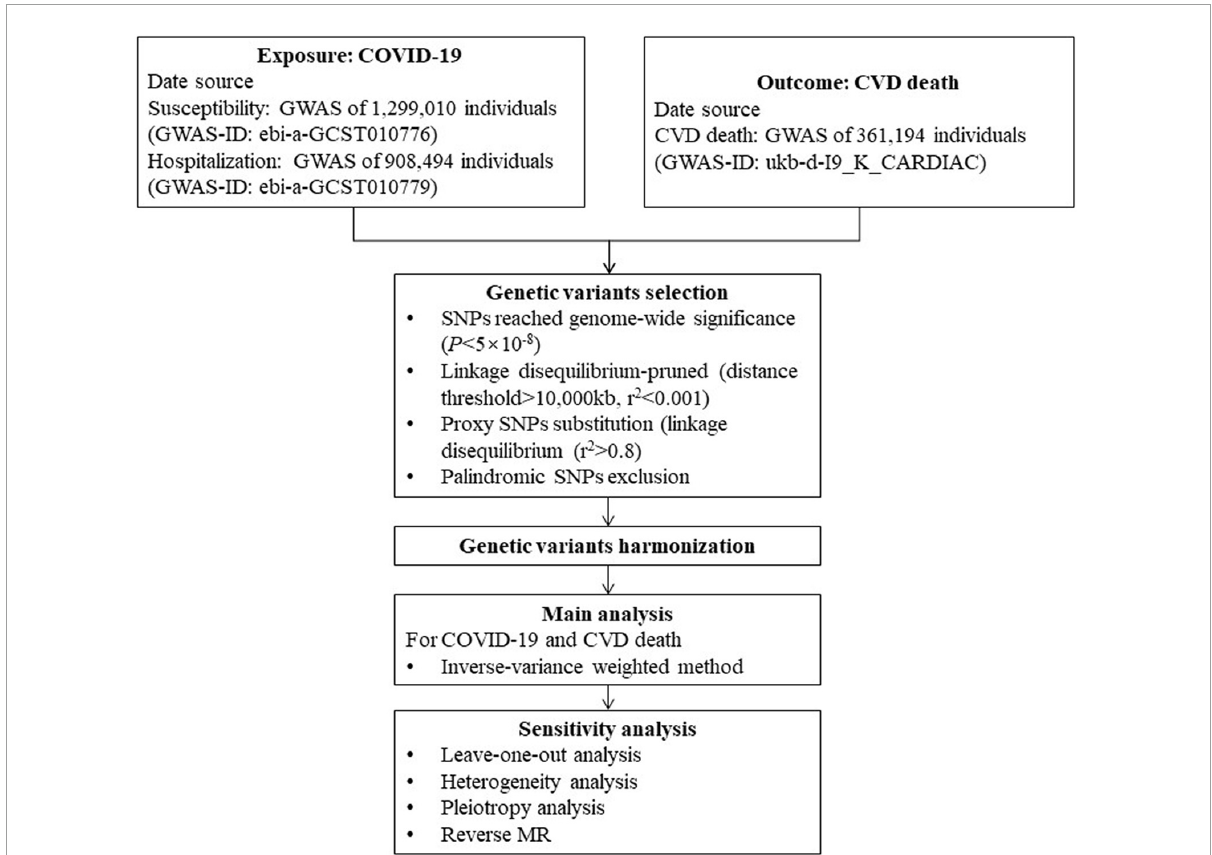
FIGURE1 Flow chart of this Mendelian randomization study. COVID-19, Coronavirus disease 2019; GWAS, genome-wide association study; SNP, single nucleotide polymorphism; MR, Mendelian randomization; CVD, cardiovascular